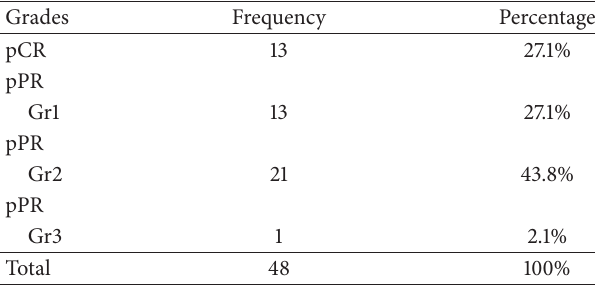
Table 5: Percentage of tumors with the tumor responses and